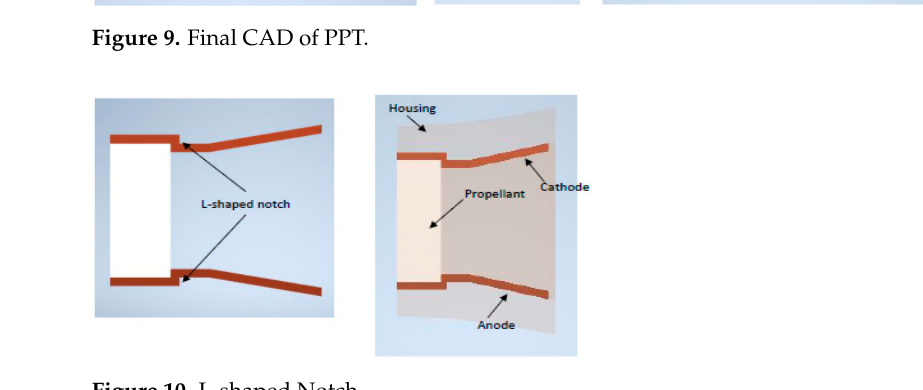
Figure 10. L-shaped Notch.